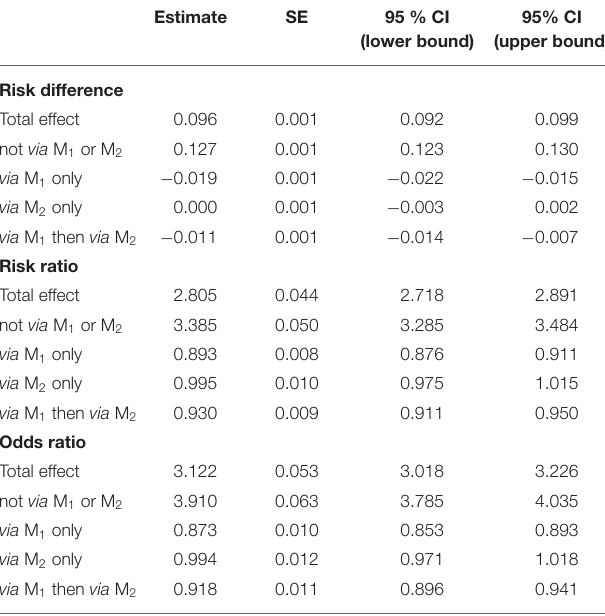
TABLE 1 | Total interventional effect of HCV infection on HCC incidence: four interventional path-specific effects with HBV viral load at baseline (M 1 ), HBV viral load at follow-up (M 2 ) as mediators in scales for risk difference, risk ratio, and odds